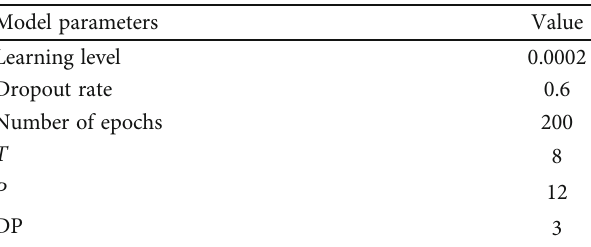
Figure 4: The expected prediction performance of the compared model versus our proposed model models. Table 3: The parameters of our model.